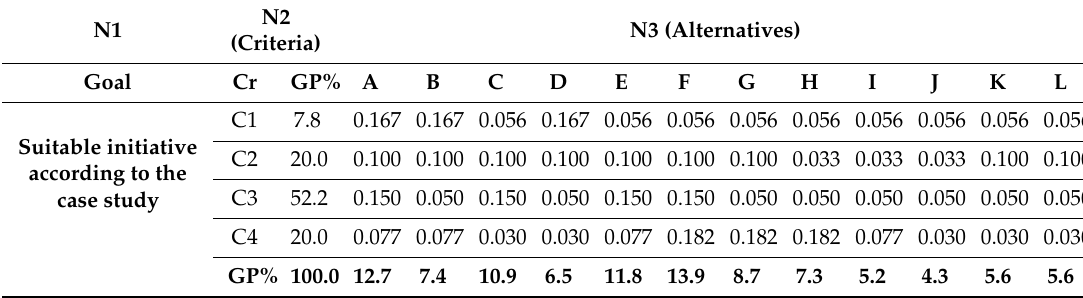
Table 4. Decision-making